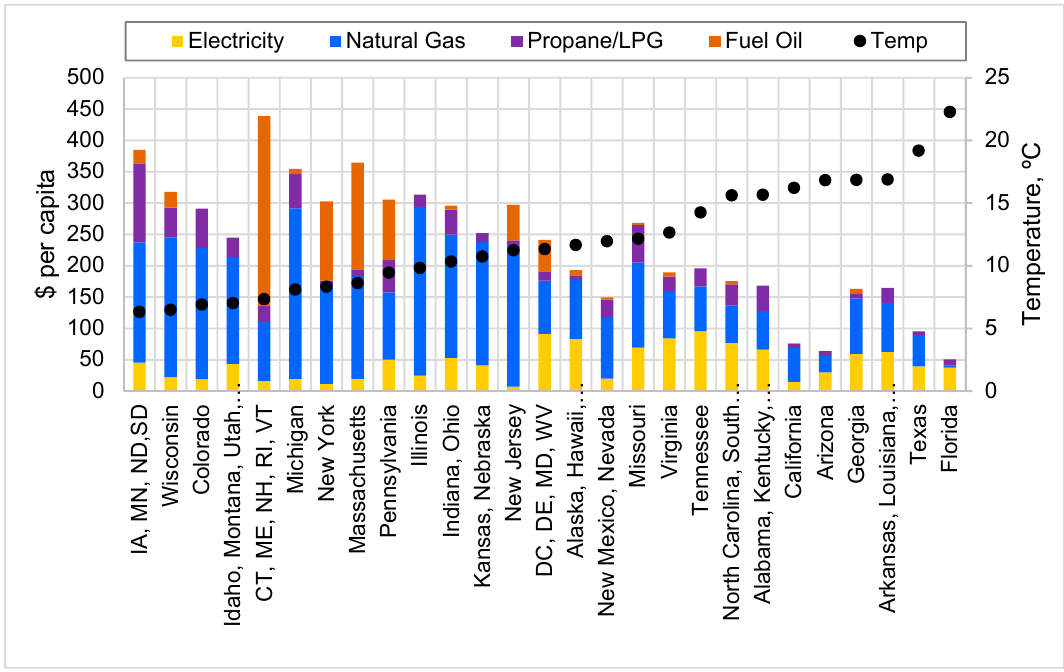
Figure A1. Residential per capita heating expenditure by fuel, and 2009 temperature, by state and state group.